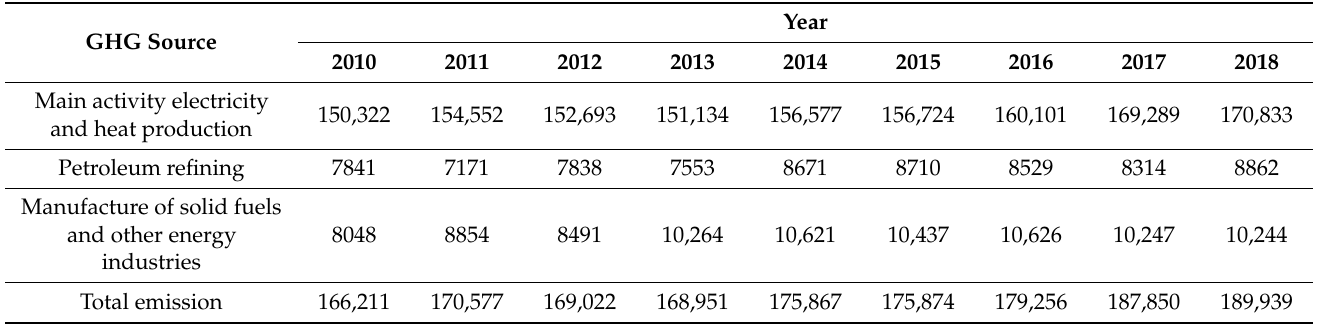
Figure 3. Pie chart of GHG emissions from the energy industries in terms of GHG sources in 2018 [18].